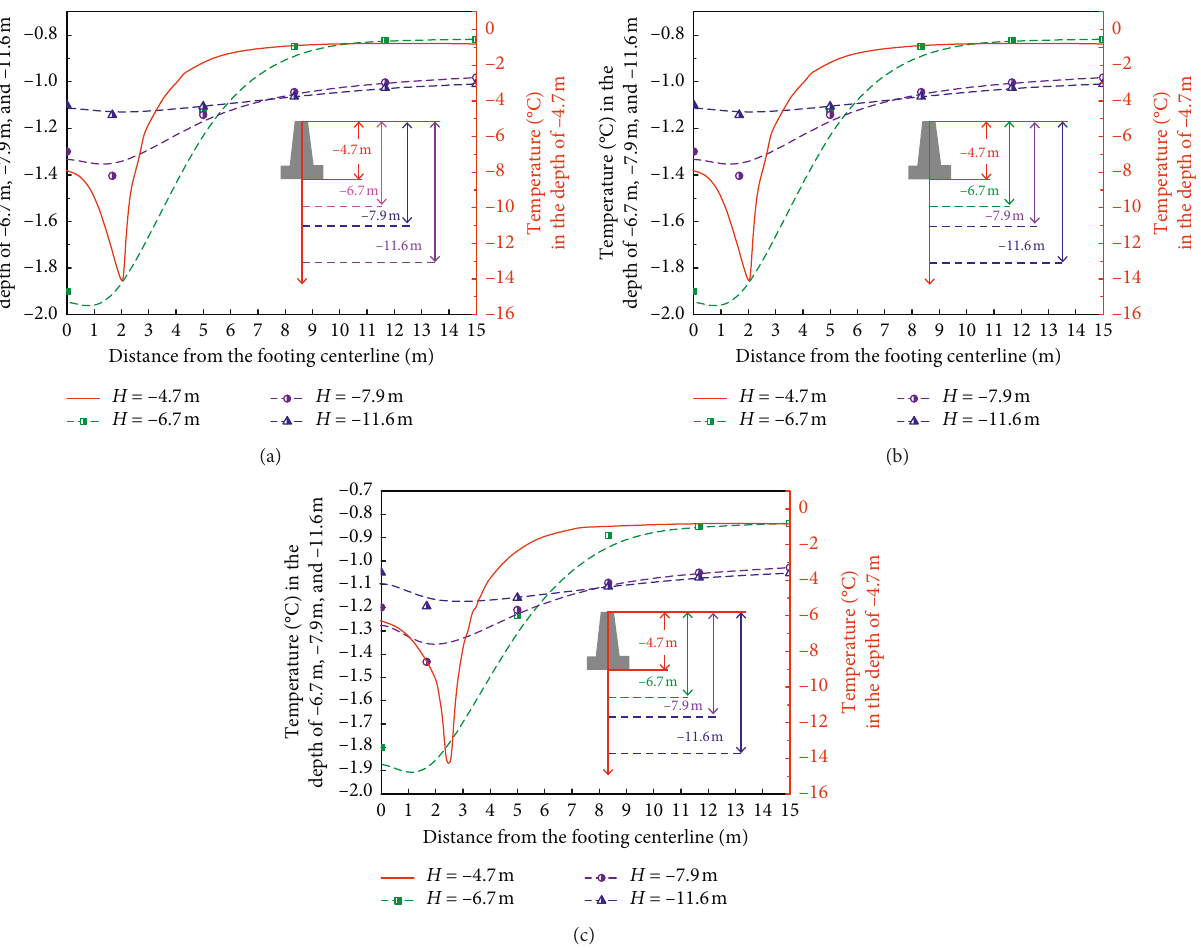
Figure 12: Horizontal temperature distribution at different depths. (a) D � 4m. (b) D � 4.5m. (c) D �